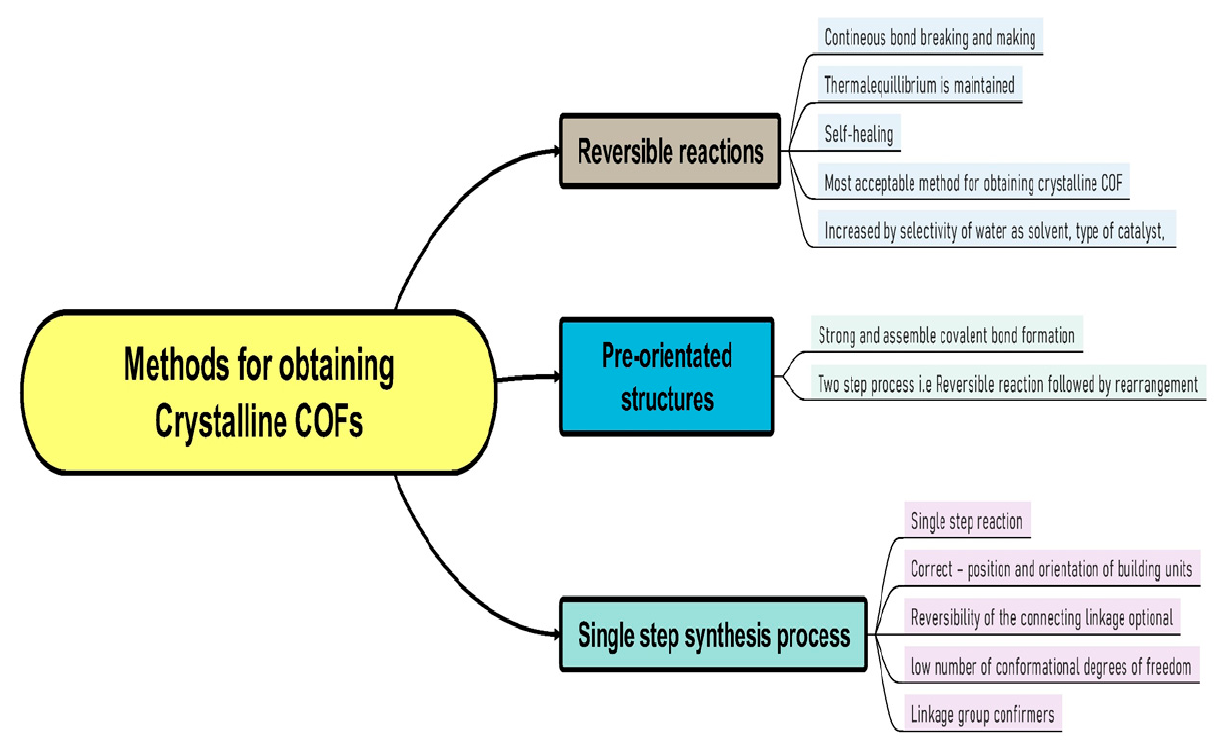
Figure 5. Three different methods to obtain good crystallinity COFs.